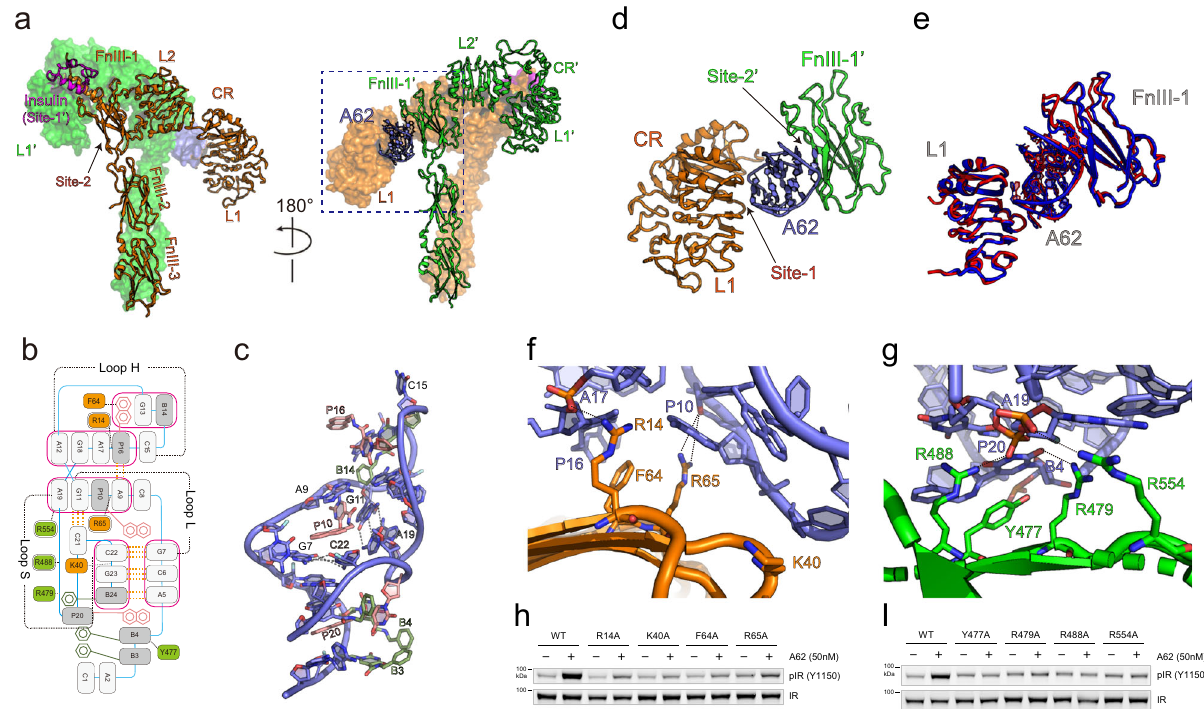
Fig. 2 | Cryo-EM structure of the IR Ins+A62 complex. a Half-turn views of the IR A62+Ins structure. Each promotor (orange or green) of the dimer is shown in surfacerepresentationorribbonrepresentation.TheA62aptameriscoloredviolet and the insulin is colored magenta. b Cartoon representation of the A62 structure. Labels for the modi fi ed parts on the 2 ′ carbon in the ribose sugar (d, f, m) are omitted for clarity. PX and BX represent (5-[ N -(1-naphthylmethyl)carboxamide]-2 ′ - deoxyuridine) and (5-[ N -benzylcarboxamide]-2 ′ -deoxyuridine), respectively. X is the nucleotide number. The A62-interacting residues are shown; the stacking interactions are shown in pink boxes, base pairings are shown in yellow dots, the FnIII-1 ′ -base interactions are in green boxes, the CR and L2 residue-base